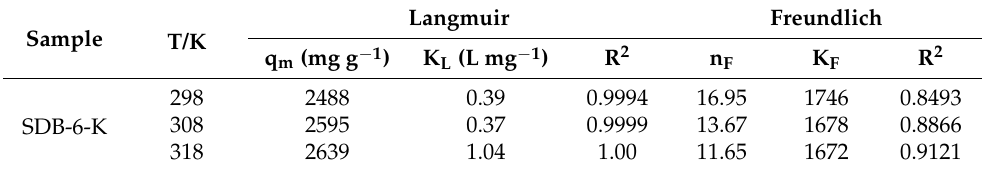
Table 4. Isotherm model parameters for the adsorption of MB onto SDB-6-K at different temperatures. Langmuir Sample T/K